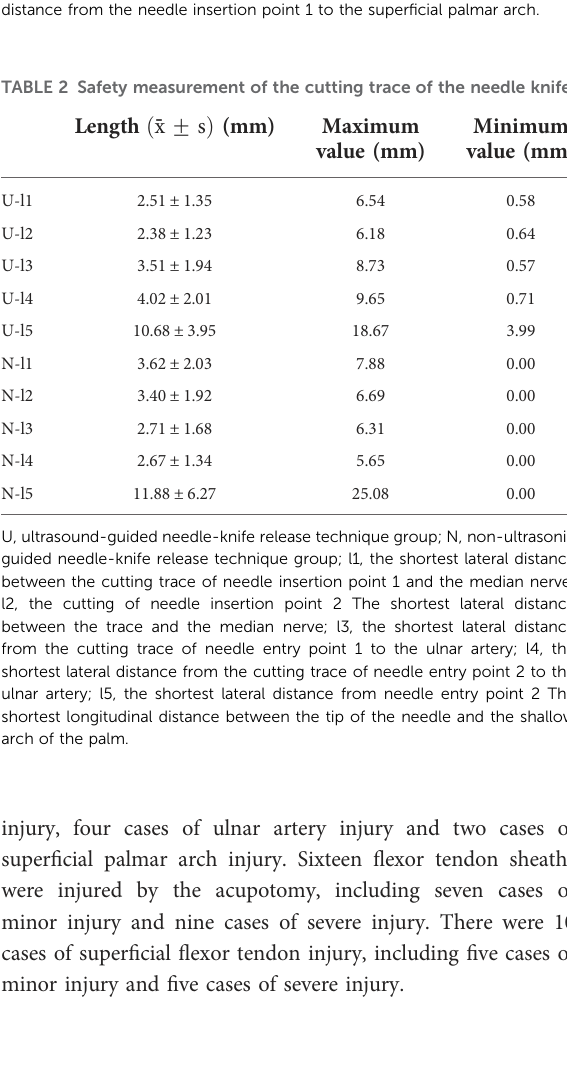
Horizontal distance; L3, the shortest horizontal distance from the needle insertion point 1 to the ulnar artery; L4, the shortest horizontal distance from the needle insertion point 2 to the ulnar artery; L5, the shortest longitudinal distance from the needle insertion point 1 to the super fi cial palmar arch.